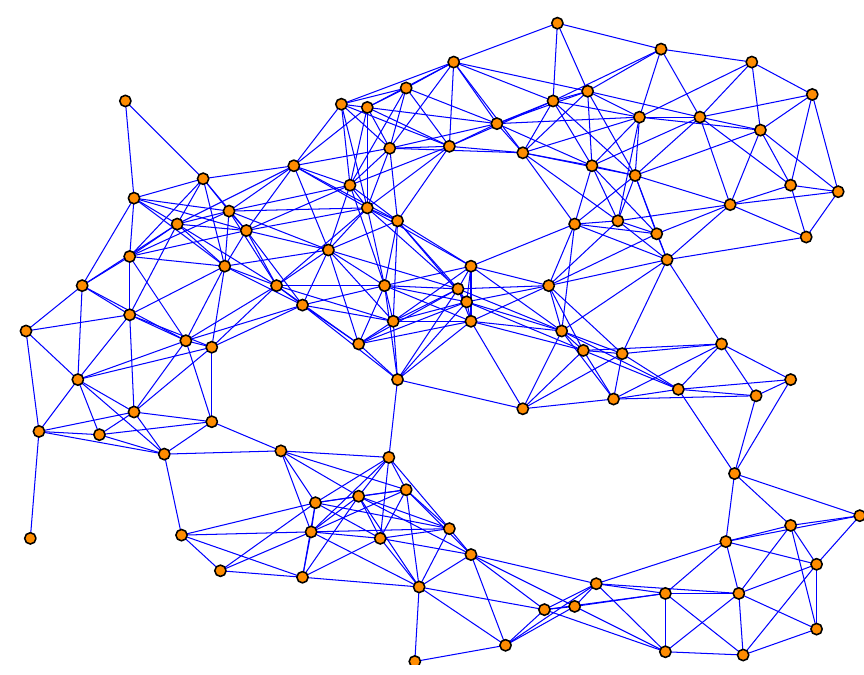
Figure 13. The topology of the sensor network with 100 sensor nodes.